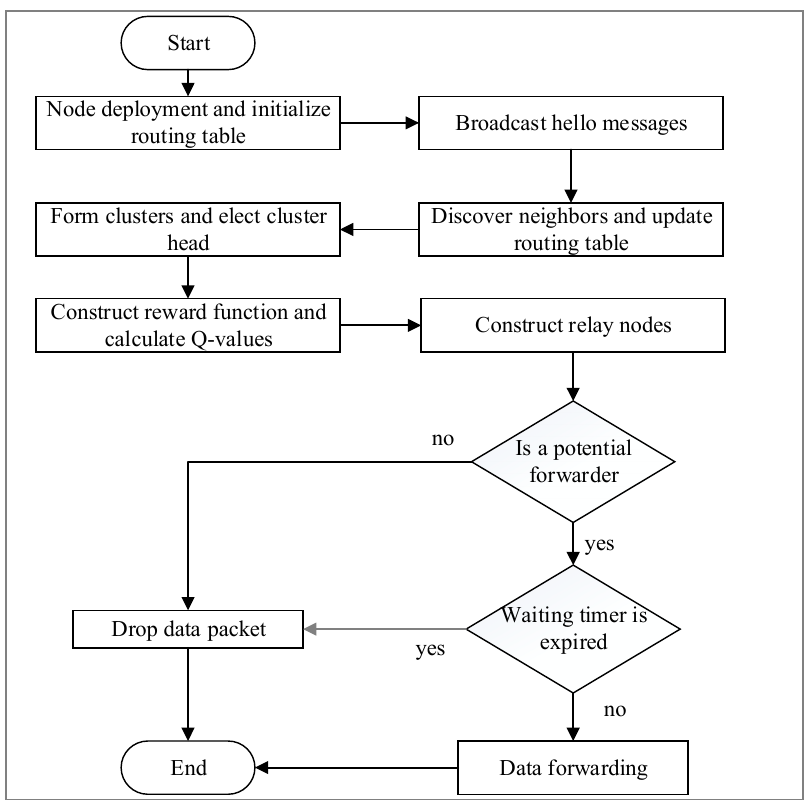
Figure 2. Flowchart of the SROA protocol. Table 1. List of symbols.